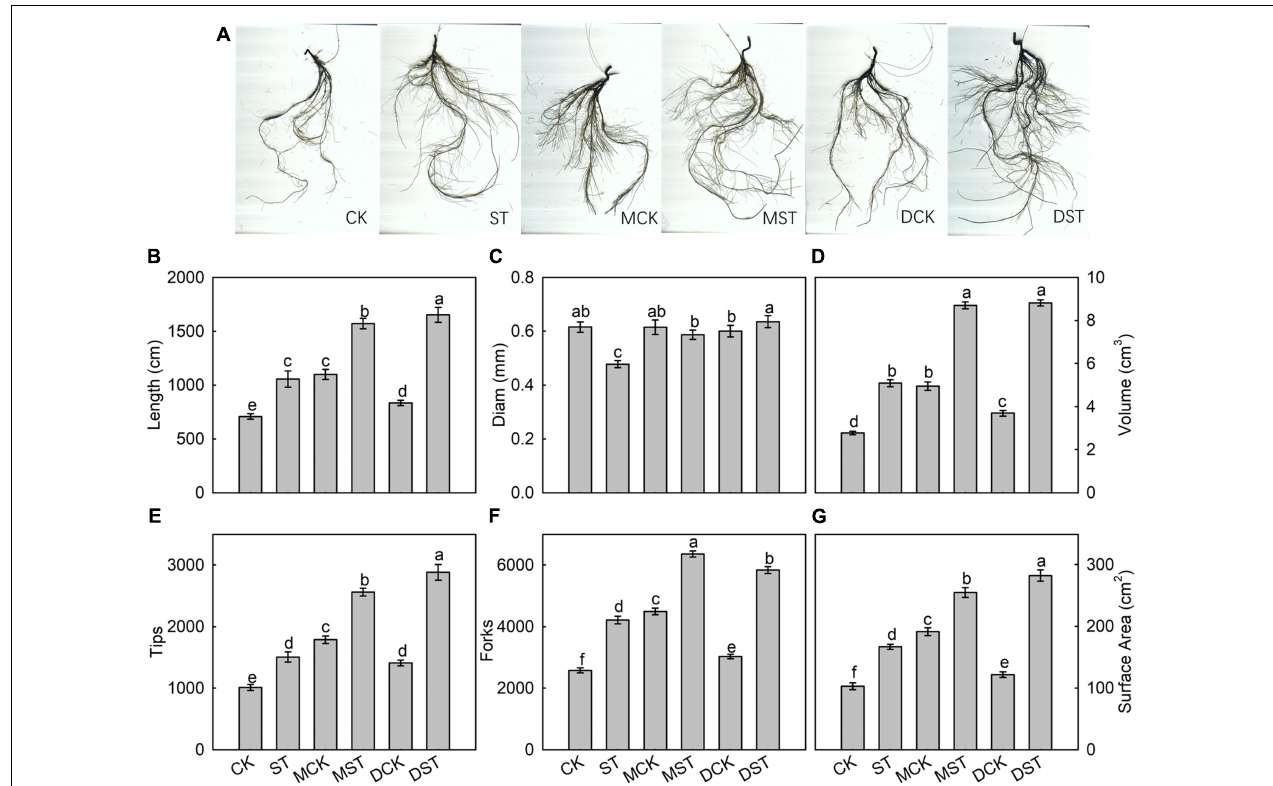
FIGURE 2 | Effect of melatonin and dopamine on root system architecture of Malus hupehensis plants grown 20 days under different N levels and material treatments. (A) Root morphology. (B) Length. (C) Diam. (D) Volume. (E) Number of root tips. (F) Number of root forks. (G) Surface area. Data are means ± SD ( n = 10). Values not followed by same letter denote significant differences by Tukey’s multiple range tests ( P < 0.05). CK, 2 mM K 15 NO 3 solution; ST, 0.1 mM K 15 NO 3 solution; MCK, 2 mM K 15 NO 3 solution with 0.1 µ mol/L melatonin; MST, 0.1 mM K 15 NO 3 solution with 0.1 µ mol/L melatonin; DCK, 2 mM K 15 NO 3 solution with 100 µ mol/L dopamine; DST, 0.1 mM K 15 NO 3 solution with 100 µ mol/L